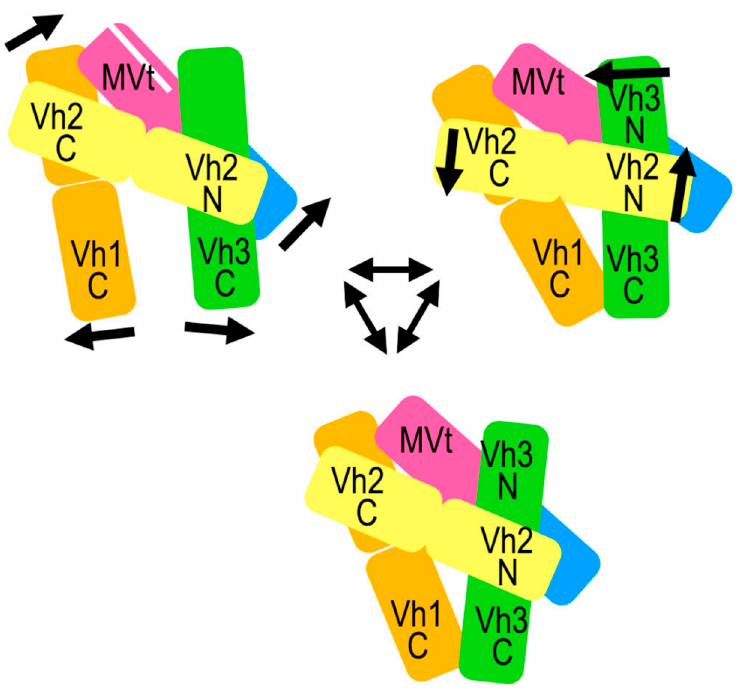
Figure 7. Mechanism of primed interface states exhibited by metavinculin. The cartoon representation of the overall conformation, similar to our crystal structure, is as depicted in the bottom. A slight twist in the four-helix bundles of Vh2 and Vh3 leads to the second H1’-parallel conformation (top right). Either of the H1’-parallel conformations (top right or bottom) transitions to the H1’-kinked conformation accommodating very large movements in the Vh1, Vh3, Vt2, and MVt subdomains with the separation of α -helix H1’ depicted with white separator. (top left). The interplay between these states as seen in our cryogenic electron microscopy structures provides a glimpse of the primed interface state of metavinculin. The subdomains are color coded to represent Vh1 (orange), Vh2 (yellow), Vh3 (green), Vt2 (blue), and MVt (purple). The single arrows indicate dhte domain movements, the double arrows the transitions from one metavinculin conformer to another.